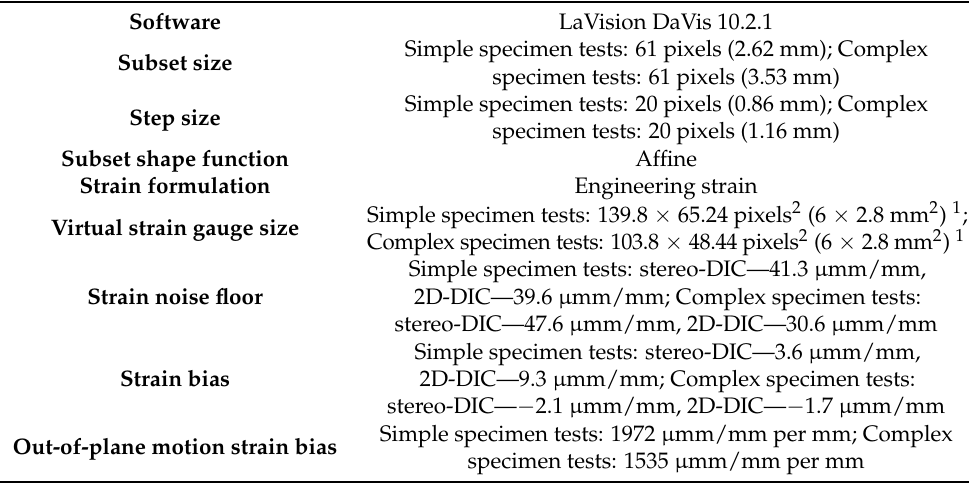
Table 2. Parameters used in the DIC analysis. Parameters were the same for both tests, except where stated to be